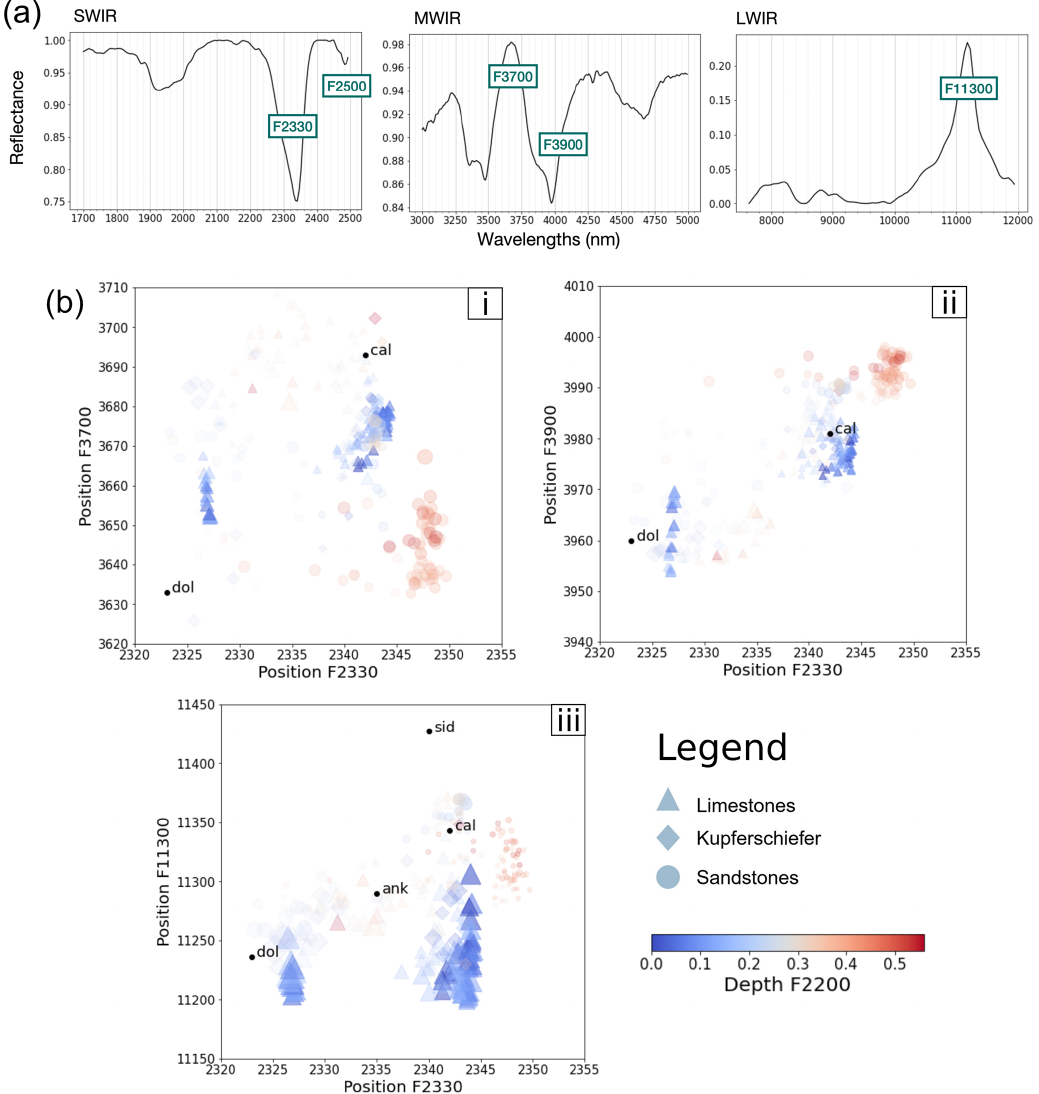
Figure 6. Example spectra (a) showing the dominant carbonate absorption positions in the SWIR–MWIR–LWIR spectral range. The 10cm averaged positions of these features (i. F3700; ii. F3900; iii. F11300) are plotted in (b) using the F2330 feature as a reference. Size is proportional to the depth of the feature on the y axis, and transparency is proportional to the depth of the F2330 feature. The colour indicates the depth of the F2200 feature and serves as a proxy for clay mineral abundance. Black points (cal refers to calcite; dol refers to dolomite; sid refers to siderite; ank refers to ankerite) show reference positions from the USGS spectral library (Kokaly et al., 2017) and from Green and Schodlok (2016) for